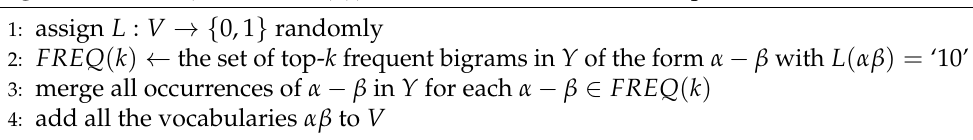
Algorithm 2 LCP ( Y , V , FREQ ( k